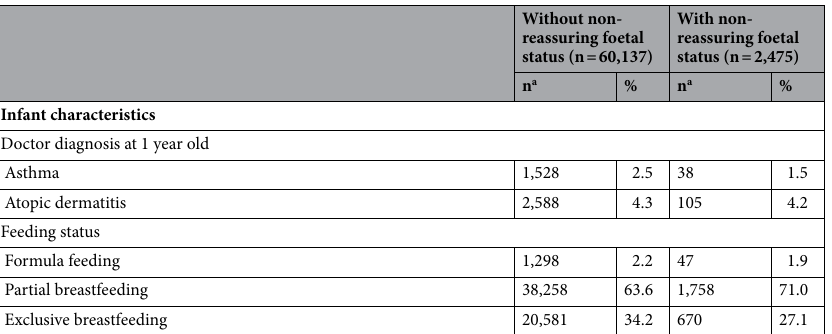
Table 1. Baseline characteristics of the study population. a Numbers in subgroups do not equal the overall number because of missing